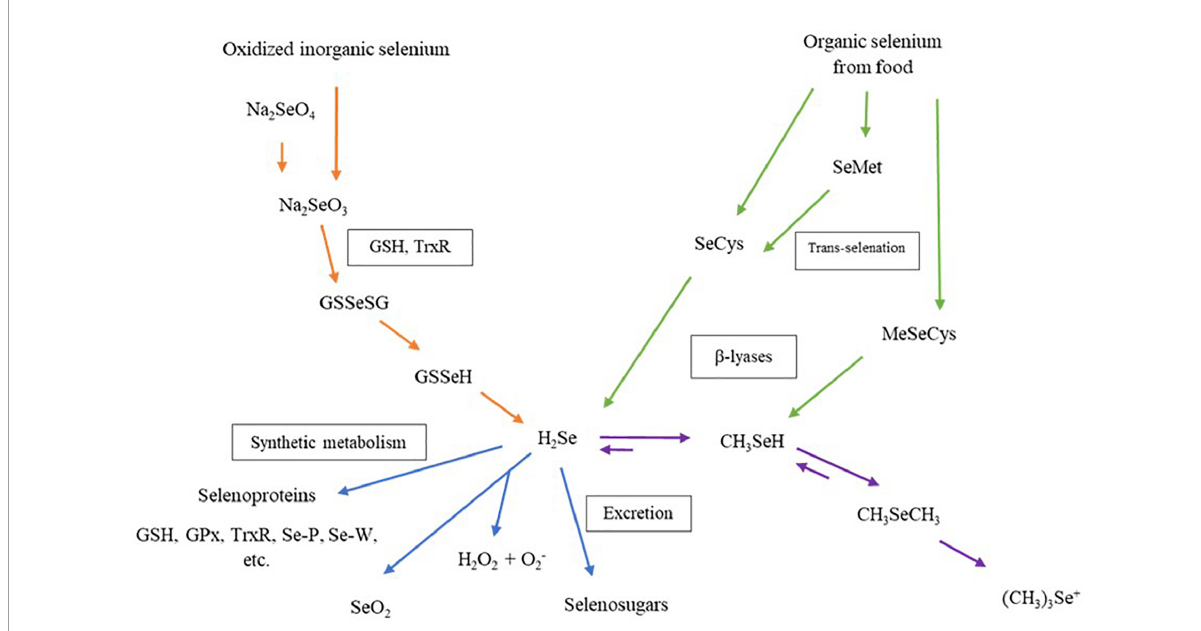
FIGURE4 Metabolism of dietary selenium compounds in human cells. Na 2 SeO 4 , sodium selenate; Na 2 SeO 3 , sodium selenite; GSH, glutathione; TrxR, thioredoxin reductase; GSSeGS, selenodiglutathione; GSSeH, glutathioselenol; H 2 Se, hydrogen selenide; GPx, glutathione peroxidase family; Se-P, selenoprotein P; Se-W, selenoprotein W; SeO 2 , selenium dioxide; H 2 O 2 , hydrogen peroxide; SeCys, selenocysteine; SeMet, selenomethionine; MeSeCys, methylselenocysteine; CH3SeH, selenol; CH 3 SeCH 3 , dimethylselenide, (CH 3 ) 3 Se + , trimethylselenonium